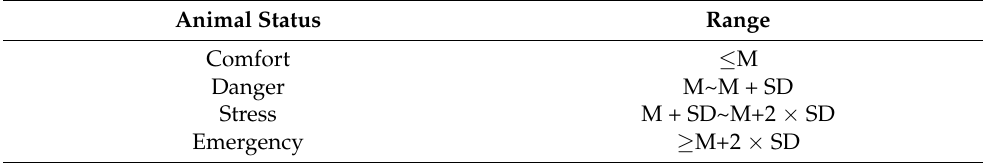
Table 1. Definition of range of animal comfort.